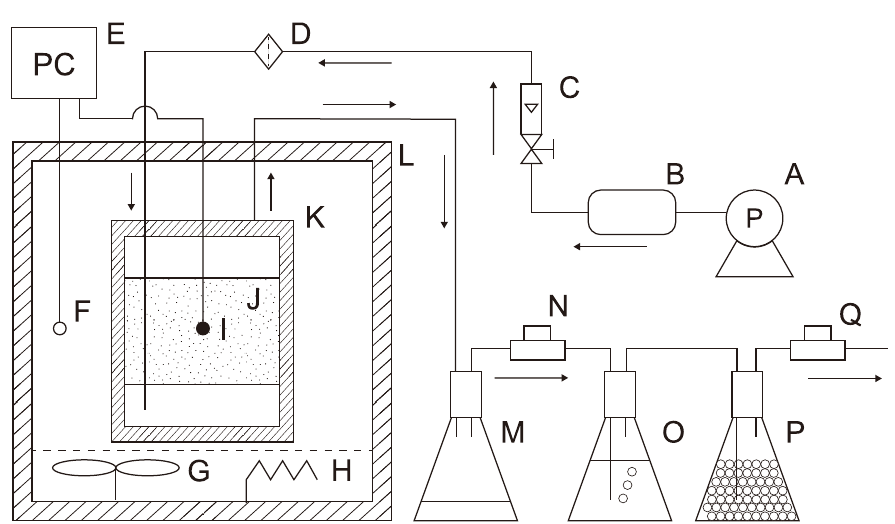
Fig 1. Experimental setup of the reaction system. A: air compressor (replaced by a nitrogen cylinder for inert conditions); B: air receiver tank; C: flowmeter; D: sterilized filter; E: PC; F: chamber temperature; G: fan; H: heater; I: sample temperature; J: sample; K: reaction vessel; L: adiabatic chamber; M: liquid collection; N: gas sampling port; O: ammonia trap; P: silica gel; Q: oxygen